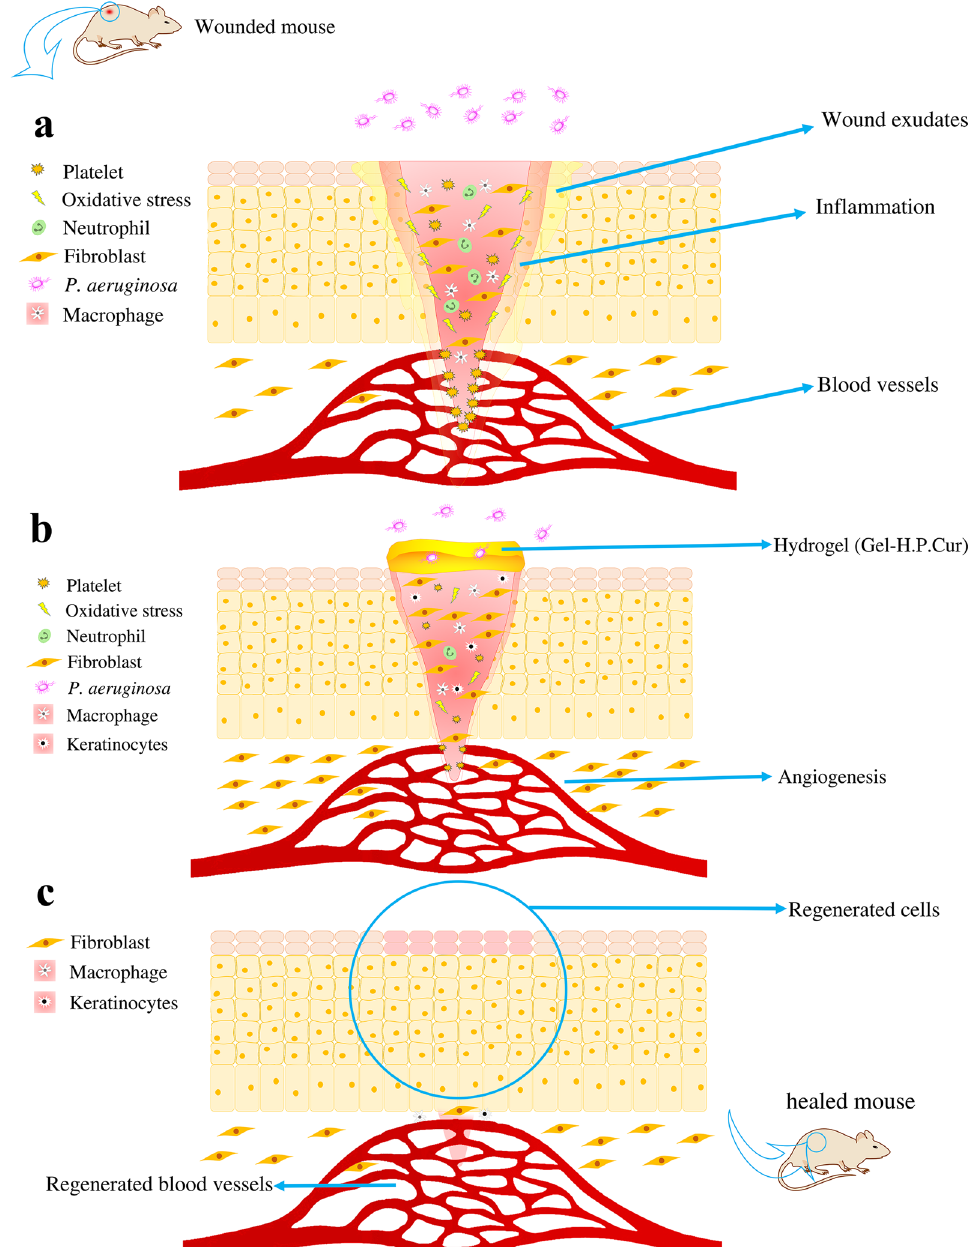
Fig. 5 Schematic illustration of promoting wound healing process in the presence of Gel-H.P.Cur. a Thickness wound formation in the skin, and attacking of opportunistic bacteria. Due to the local inflammation and swollen, the wound starts to expand. b Treating with Gel-H.P.Cur promotes the healing processes. For instance, bacteria are prevented from entering the wound bed, and gradually the swelling and local inflammation decreases and also exudates are absorbed by the hydrogel. Proliferation of fibroblasts and angiogenesis are stimulated by both HA and curcumin. c After treatment with Gel-H.P.Cur the wounded tissue is completely regenerated and a slight scar is seen on the wound